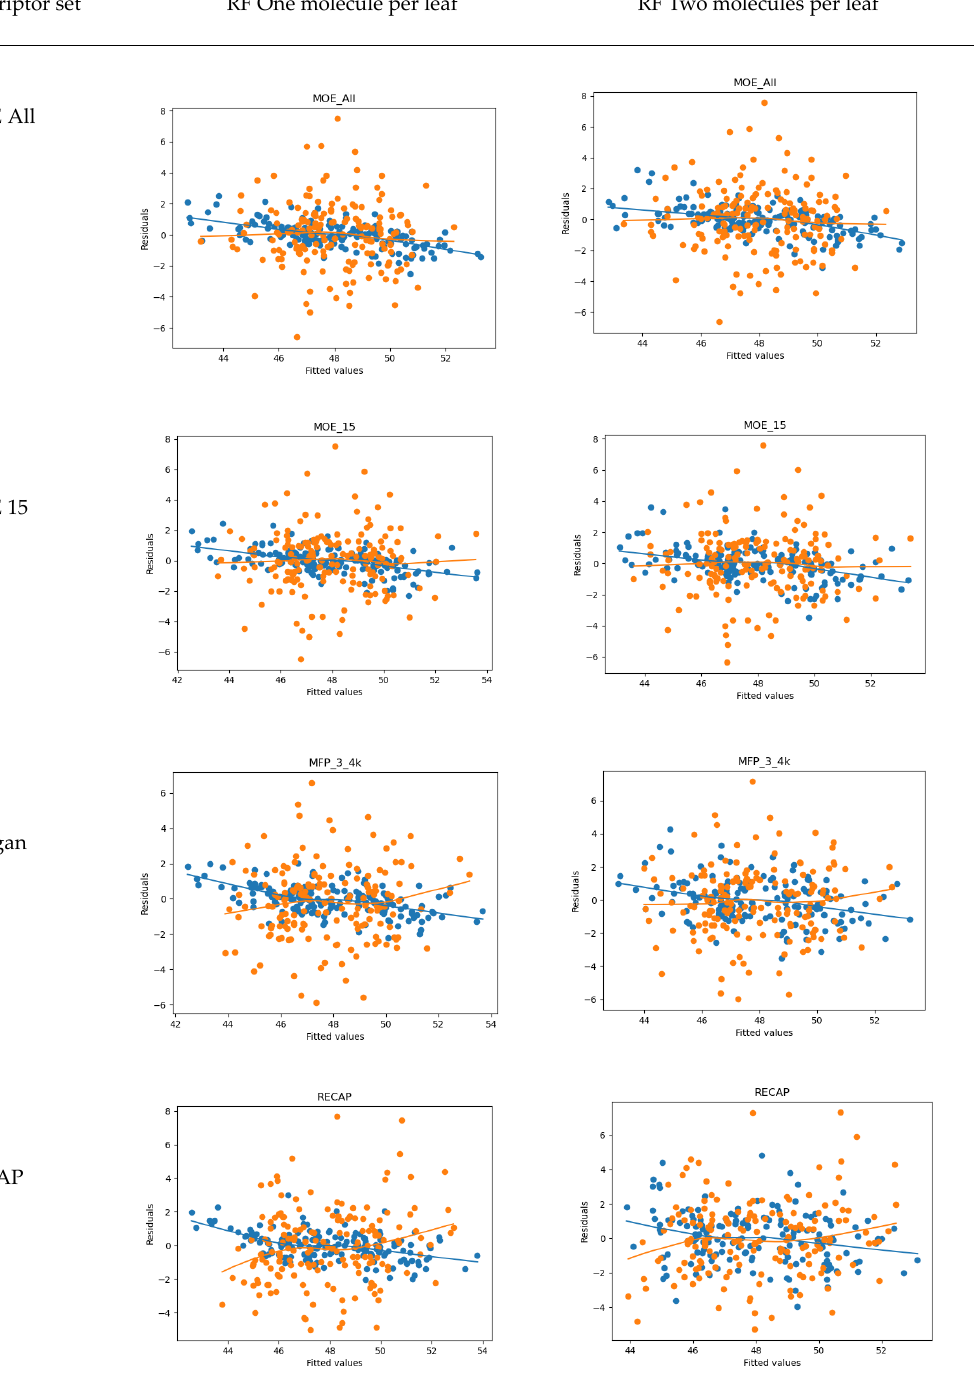
Figure 3. Diagnostic plots for the Random Forest Regressor models on the training set (blue points) and leave-one-out cross-validation (orange points) for various considered descriptor sets.